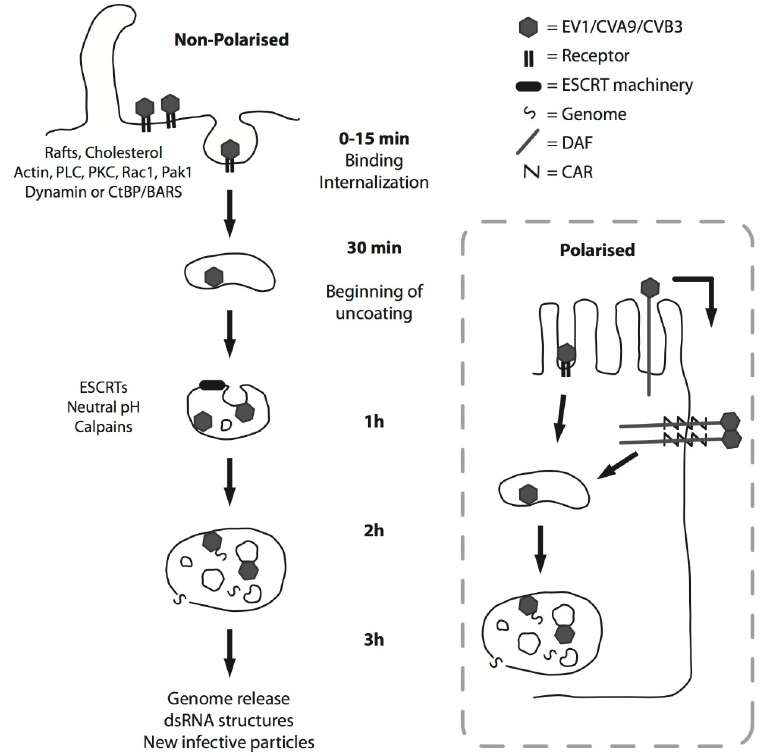
Figure 2. A schematic representation of the EV-B entry pathway in both nonpolarized ( left ) and polarized cells ( right ). See Section 2 for details.